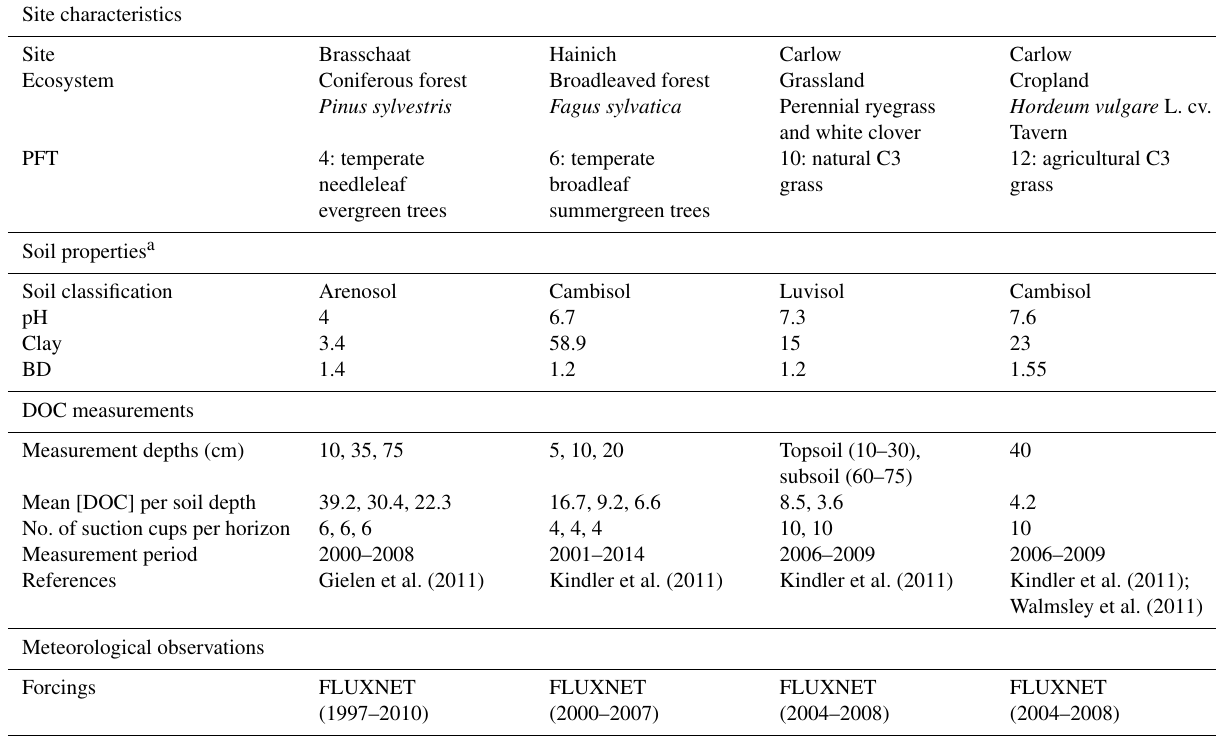
Table 2. Characteristics of the four sites used for the model